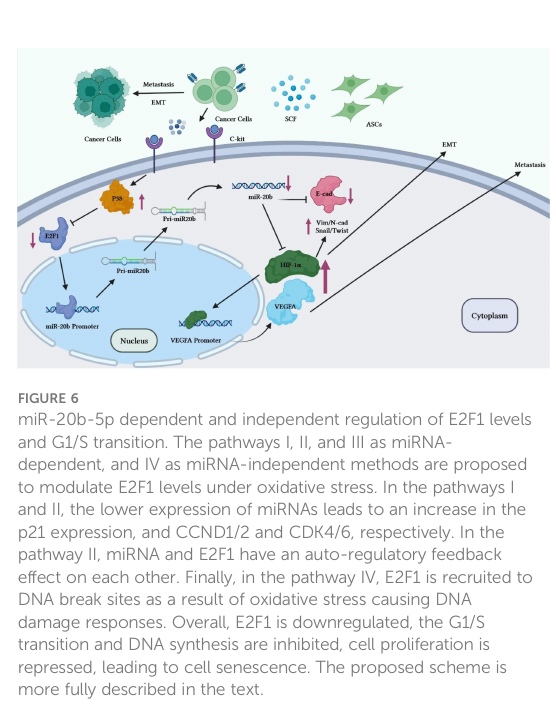
TABLE 3 Summary of the role of miR-20b in non-malignant